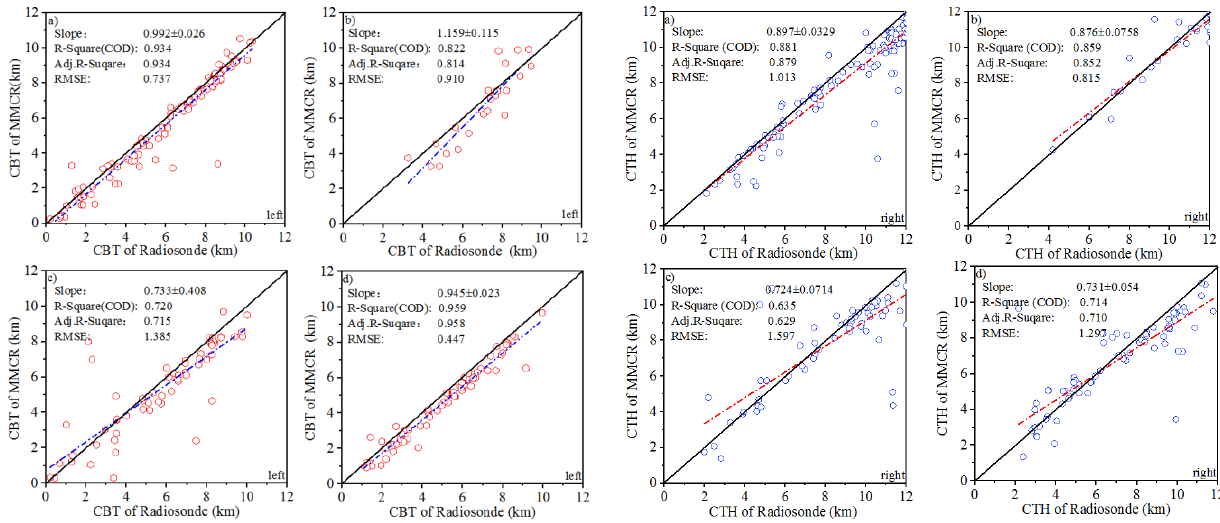
Figure 12. Adj. R-square of the CBH ( left : red point) and CTH ( right : blue point) detection by the radiosonde and MMC R. ( a ) Spring, ( b ) summer, ( c ) autumn, and ( d ) winter. Blue and red dotted lines represent the fitted lines of the CBH and CTH detected by the radiosonde and MMCR, respectively. In the figures, the R-square (COD) is the determination coefficient, and the adj. R-square is the determination coefficient of the modified degree of freedom. The expression of the adj. R-square can be written as 𝑅 2 (𝑎𝑑𝑗) = 1 − (1 − 𝑅 2 ) ∙ (𝑛 − 1) (𝑛 − 𝑃 − 1)⁄ , where P is the number of variables, n is the number of samples, and R means R-squared. In univariate linear regression, R-squared and adjusted R-squared assessments are consistent, but the latter is more adaptable to the change in the variables. RMSE refers to the root mean square